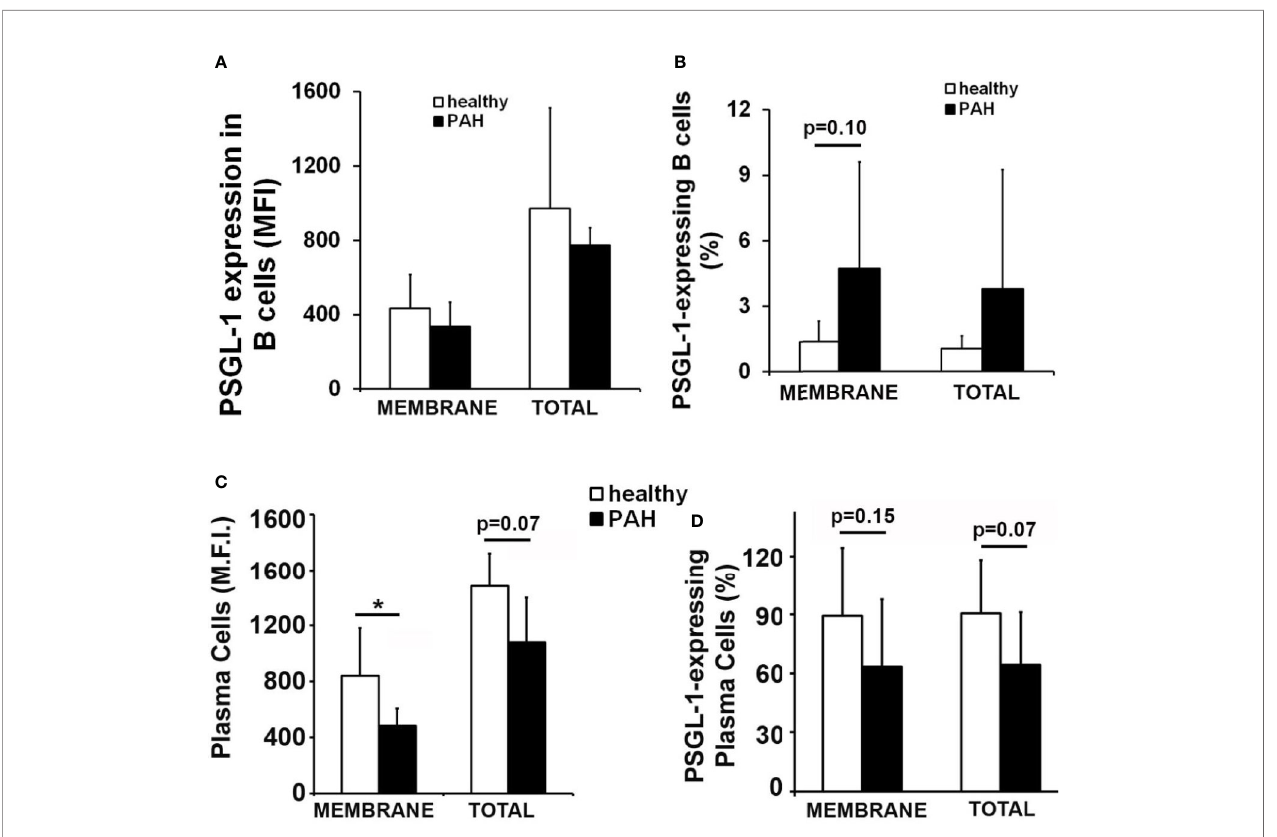
FIGURE 7 | Membrane PSGL-1 expression is reduced in circulating plasma cells of patients with pulmonary arterial hypertension. (A, B) Membrane and total expression levels of PSGL-1 (A) and percentage of PSGL-1 expressing cells (B) in circulating B cells of healthy donors and patients with pulmonary arterial hypertension (PAH). (C, D) Membrane and total expression levels of PSGL-1 (C) and percentage of PSGL-1 expressing cells (D) in circulating plasma cells of healthy donors and patients with PAH. *p < 0.05 by Mann Whitney ’ s U test. In all cases, n = 7 healthy donors and 5 idiopathic PAH